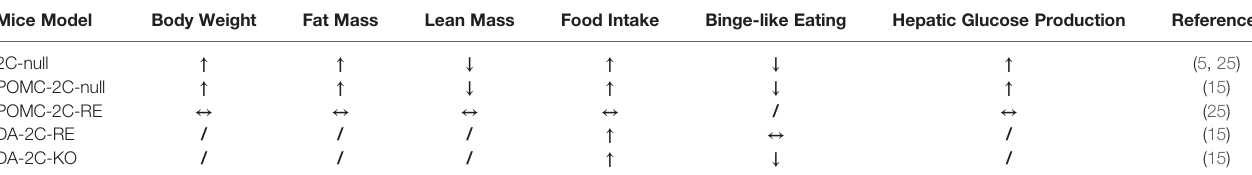
TABLE 1 | Phenotypes of the 5-HTR2C de fi cient mice.